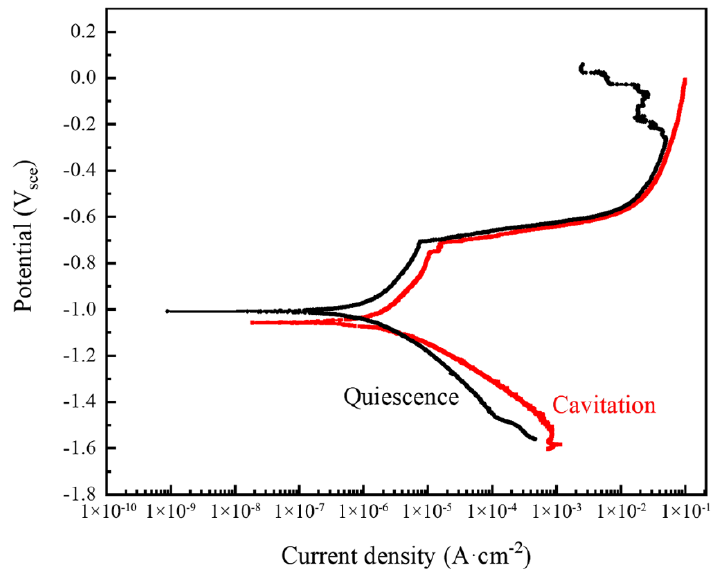
Figure 11. Potentiodynamic polarization curves of Al–5Ti alloy under quiescence and cavitation condition in 3.5 wt. % NaCl solution. Table 2. Electrochemical parameters of polarization behavior of Al–5Ti alloy in 3.5 wt.% NaCl.